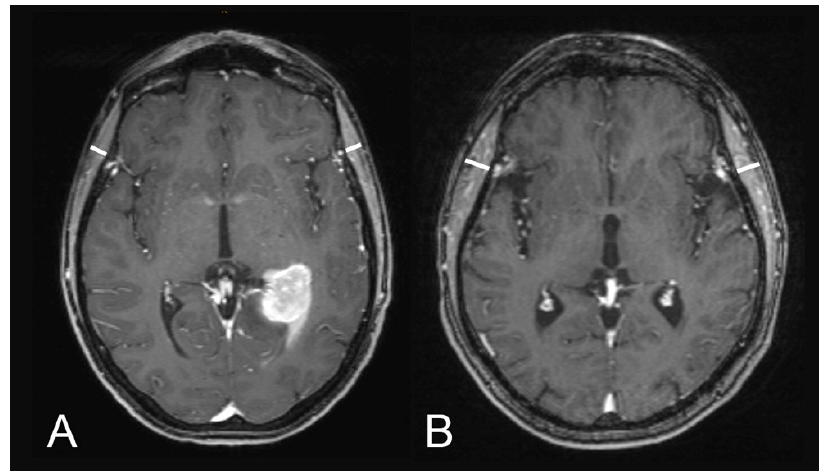
Figure 1. Illustration of TMT assessments on T1-weighted contrast-enhanced magnetic resonance images: ( A ) a 60-year-old male patient with an overall survival of one month (median TMT = 5.75 mm) and ( B ) a 51-year-old male patient with an overall survival of 73 months (median TMT = 8.1 mm).